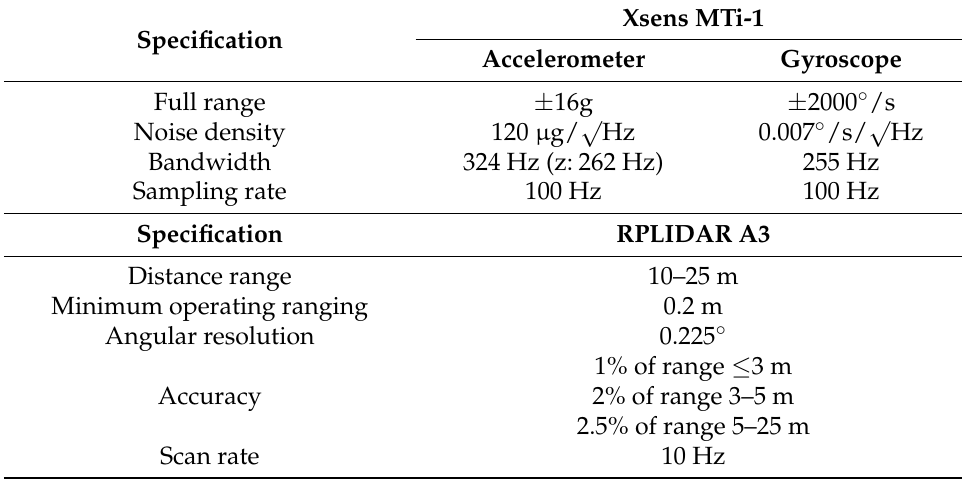
Table 1. Sensor specifications.